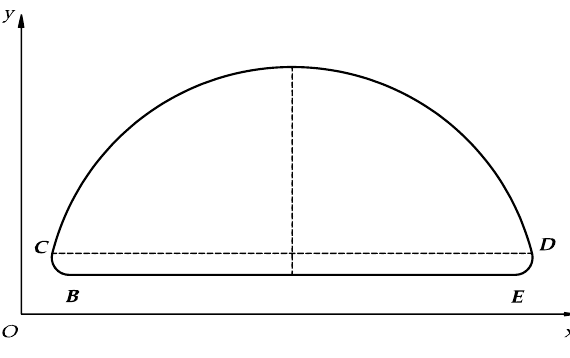
Figure 6. Optimized foot